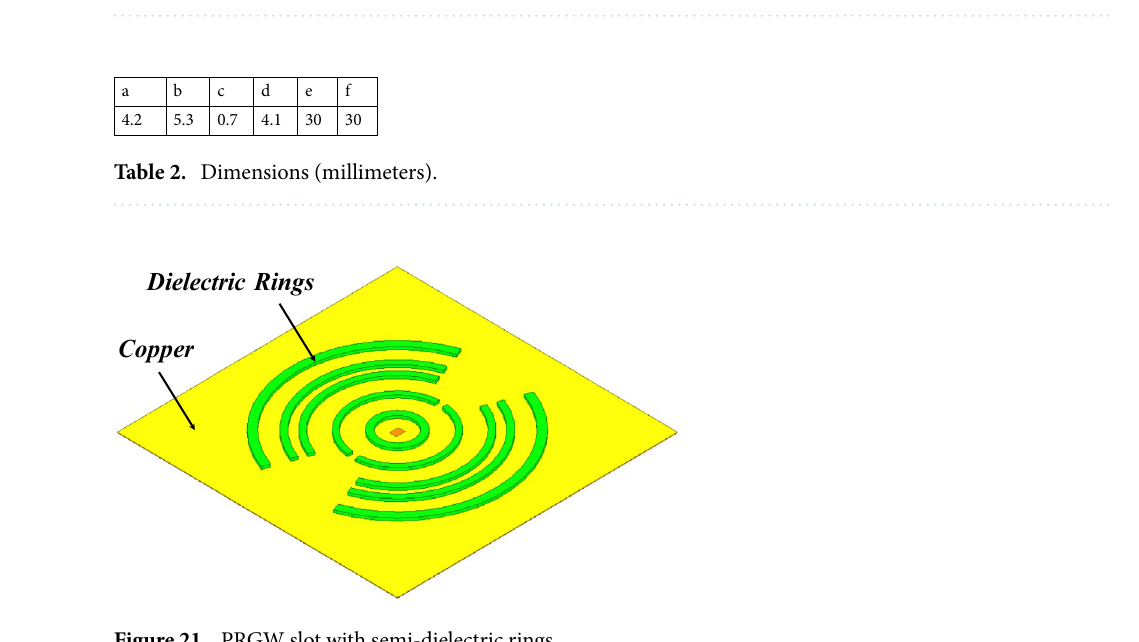
Figure 21. PRGW slot with semi-dielectric